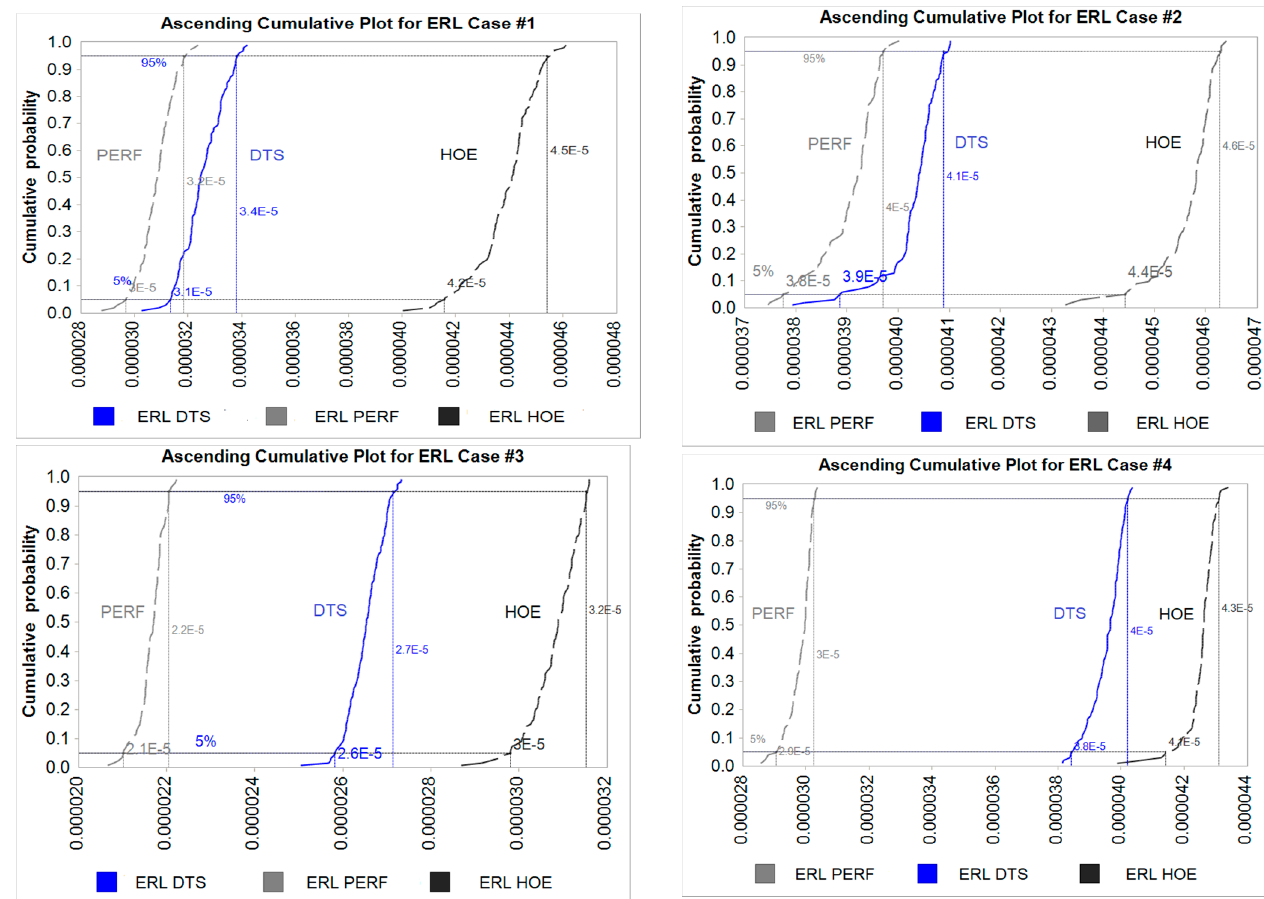
Figure 12. Cumulative Probability Distribution for Case #1 to #4—DTS, Performance & Performance with HOE. The results also indicate that uncertainties associated with the ERL point estimates are small. At the same time, the low standard deviations as shown in Table 7 signifies that the data points are closely distributed around the mean